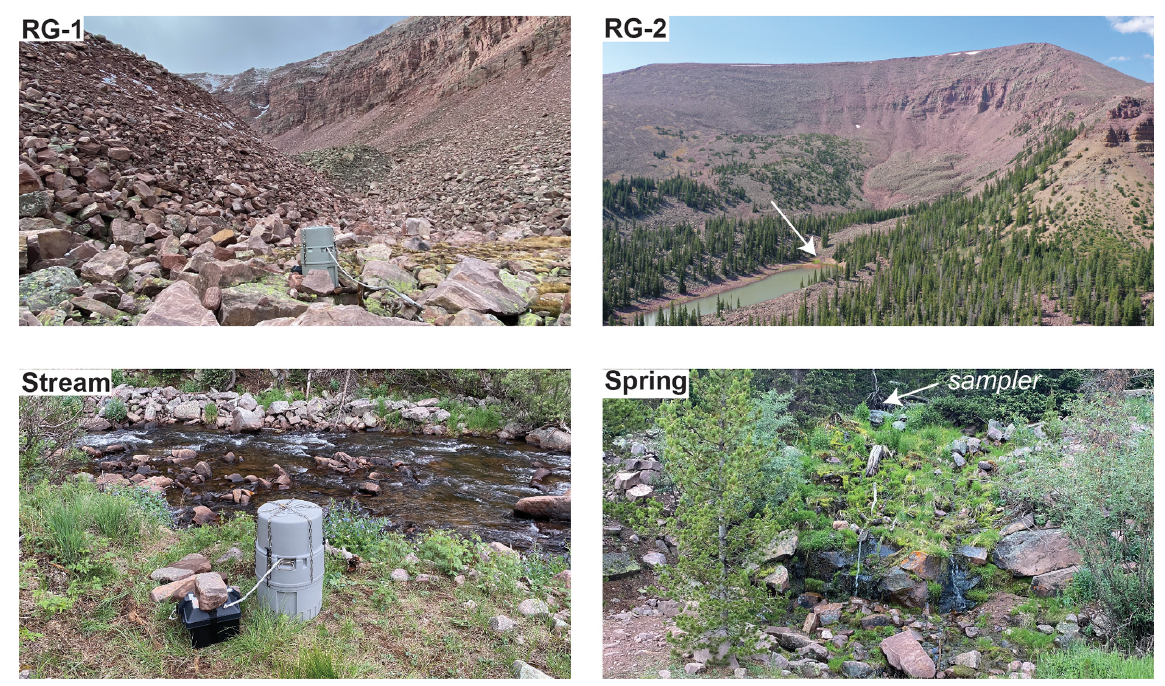
Figure 2. Pictures of water samplers at RG-1, RG-2, the Stream, and the Spring sites. Table 1. Locations, dates, and durations of water sampler